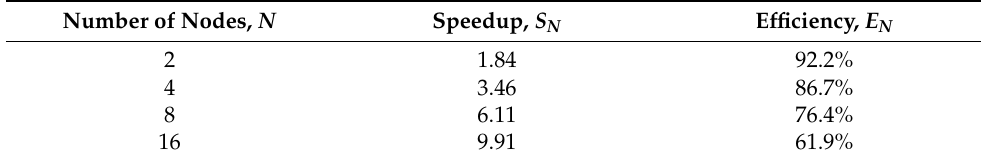
Table 2. Speedup and parallelization efficiency for the sPMEC algorithm.